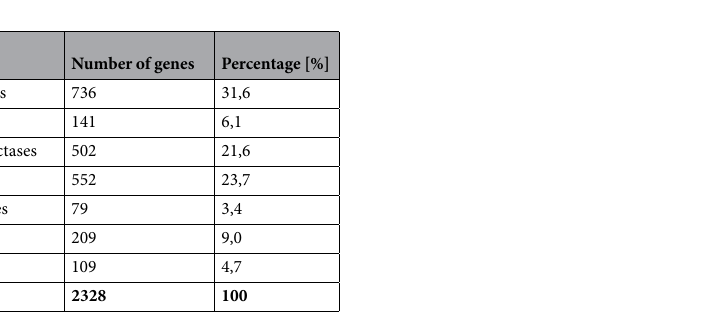
Table 3. Distribution of genes encoding enzymes within enzyme class (EC) based on KEGG pathways